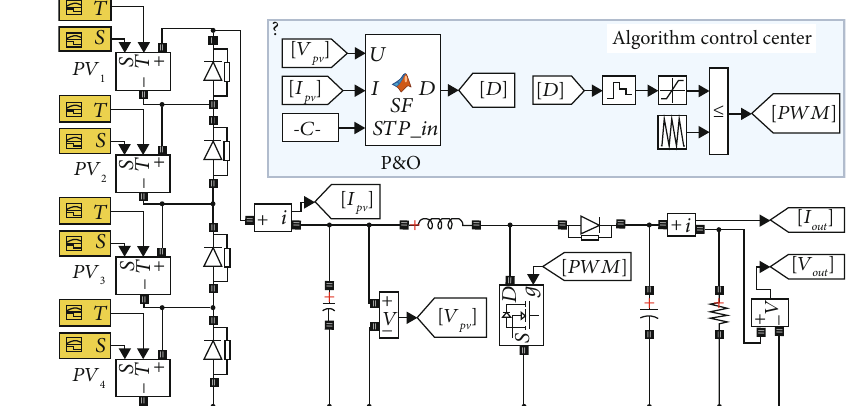
Figure 16: Traditional MPPT system.